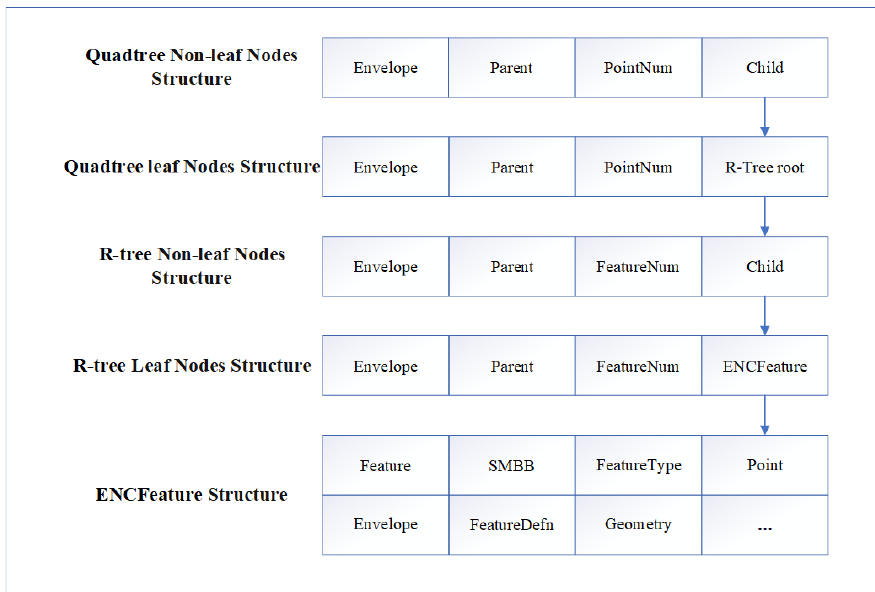
Figure 4. Data structures of 3D ENC features and spatial indexing structure.